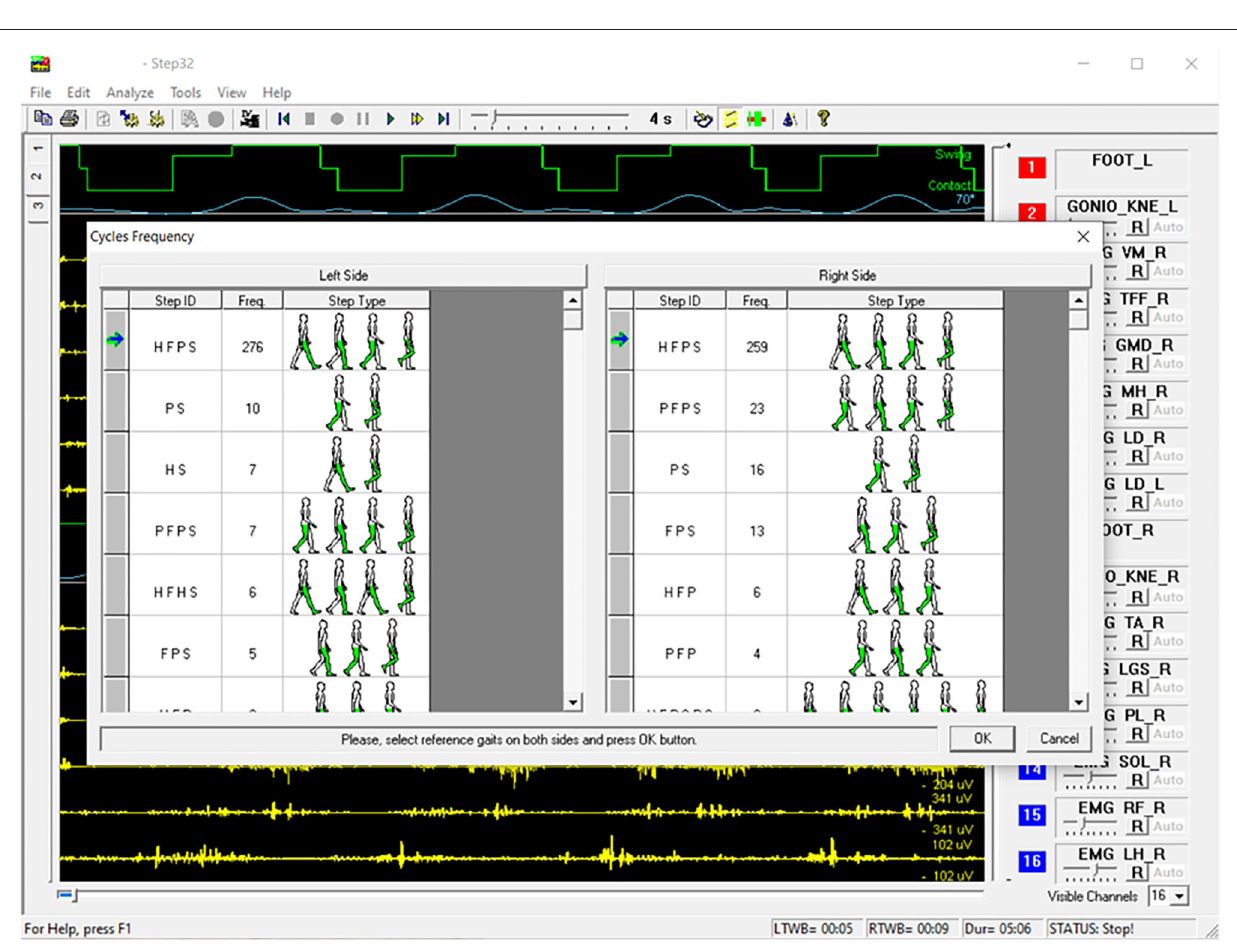
Frontiers in Neurology |